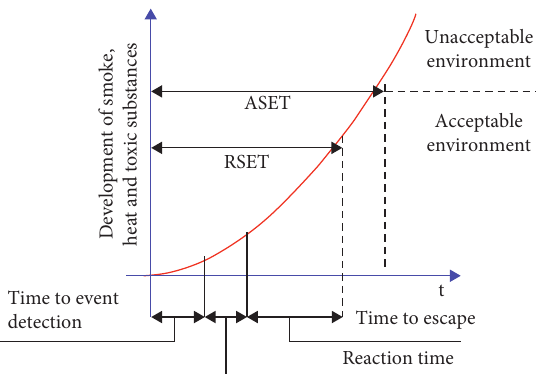
Figure 12: Meaning of times RSET and ASET